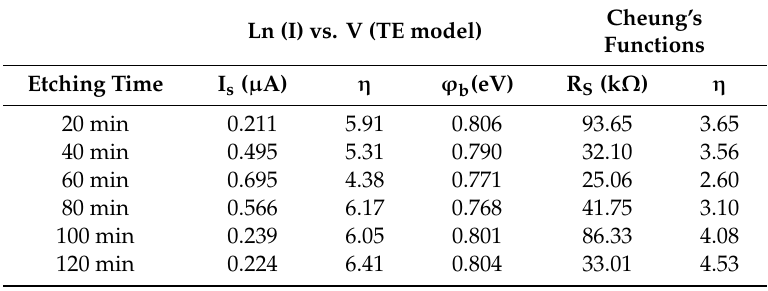
Figure 13. Plots of dV / d(LnI) vs. I of SiNWs samples (S1–S6). Table 2. Various electrical parameters determined by conventional TE and Cheung’s